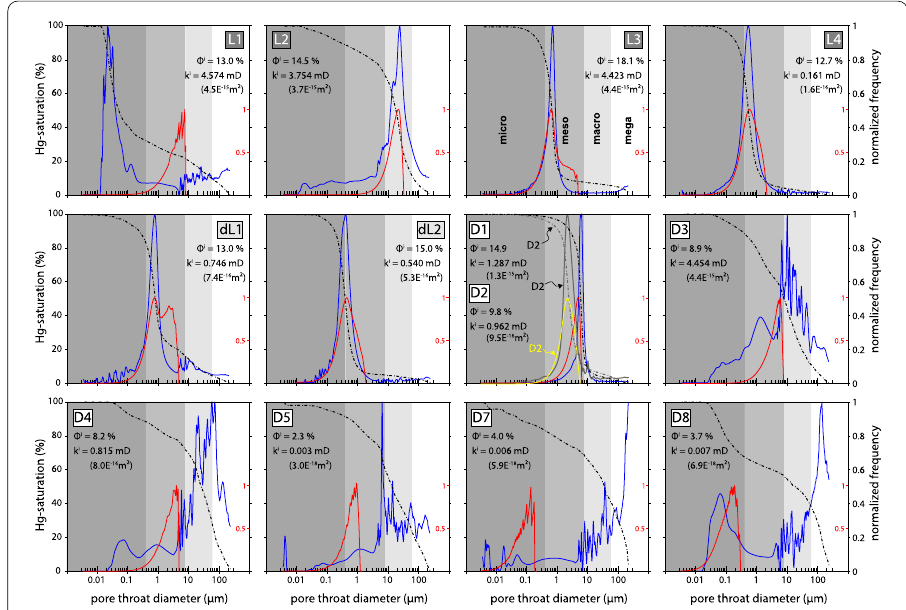
Fig. 17 Results of mercury intrusion porosimetry (MIP). Cumulative mercury volume (black dashed line) and normalized frequency (blue solid line) are plotted as a function of the pore throat entry